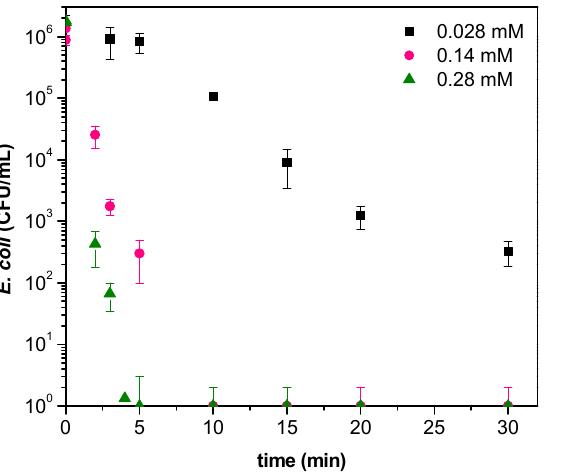
Figure 7. E. coli inactivation by chlorination with different initial concentrations of chlorine (0.028, 0.14, and 0.28 mM).